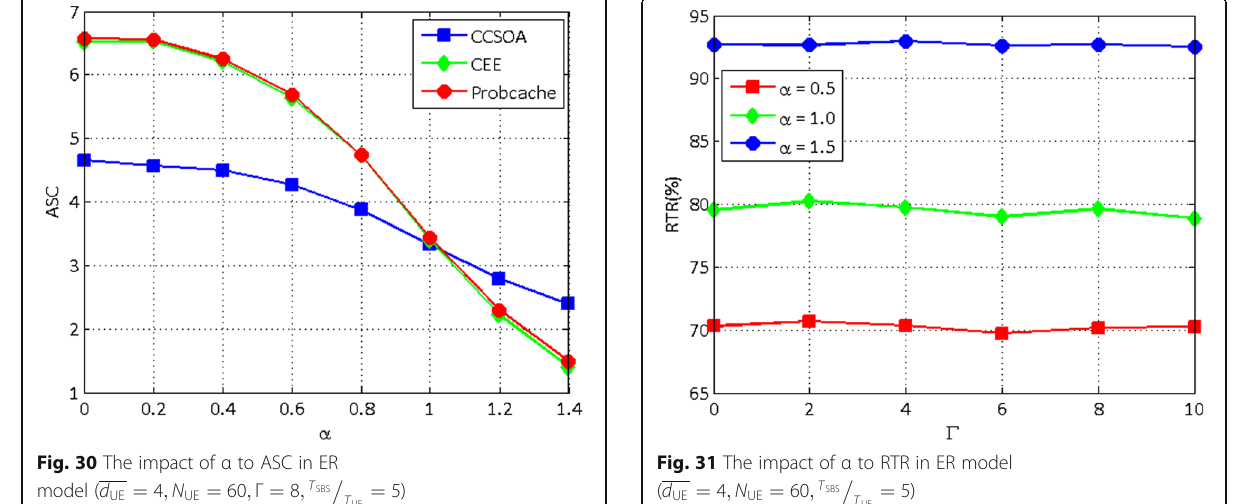
Fig. 30 The impact of α to ASC in ER model ( d UE ¼ 4 ; N UE ¼ 60 ; Γ ¼ 8 ; T SBS